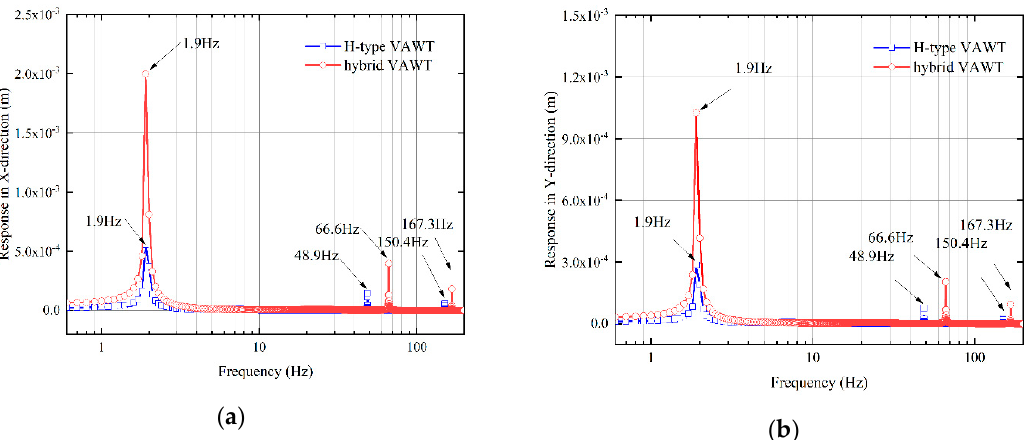
Figure 12. ( a ) Amplitude ‐ frequency responses of the 4 m ‐ mast H ‐ type and hybrid VAWTs in ( a ) X and ( b ) Y directions.